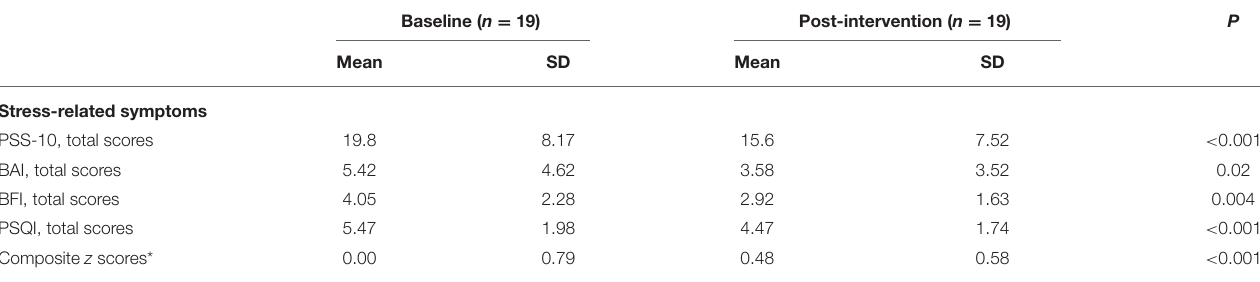
TABLE 1 | Changes in clinical outcome measures after the relaxation training.